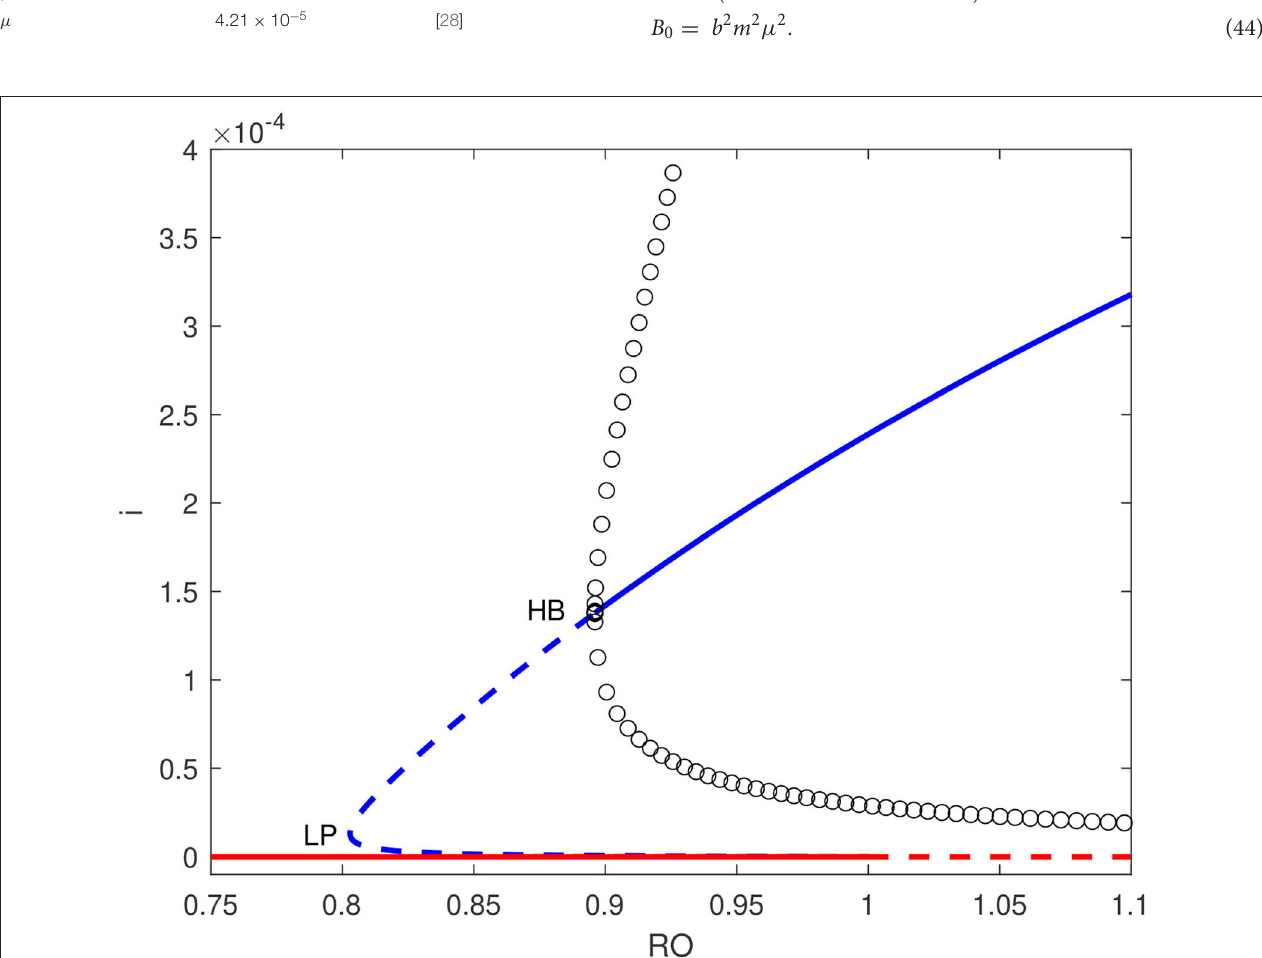
FIGURE 3 | Bifurcation diagram for b = 6.322 × 10 − 7 showing a backward bifurcation. solid line (stable branch); dashed line (unstable branch); circles (unstable periodic branches); LP (static limit point); HB (Hopf point); blue line (endemic equilibrium); red line (disease free equilibrium).